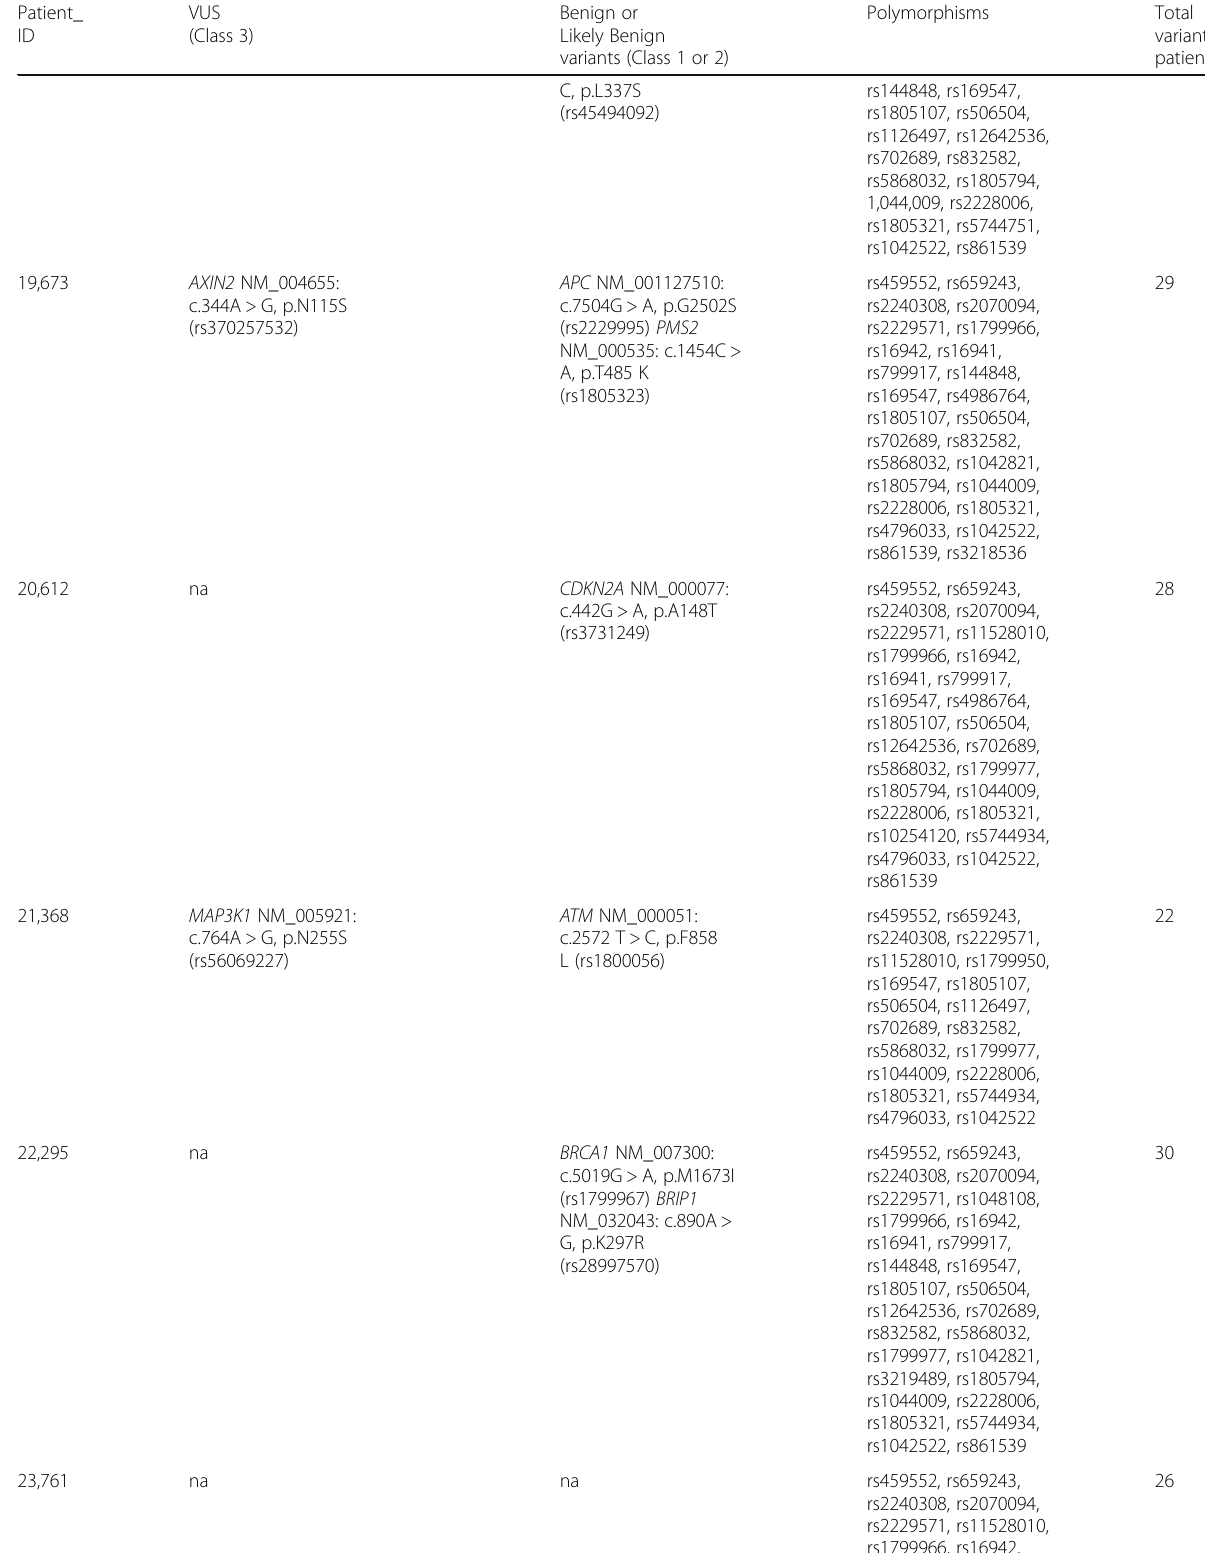
Table 2 Characterization of germline variants found among Norwegian familial CRC individuals